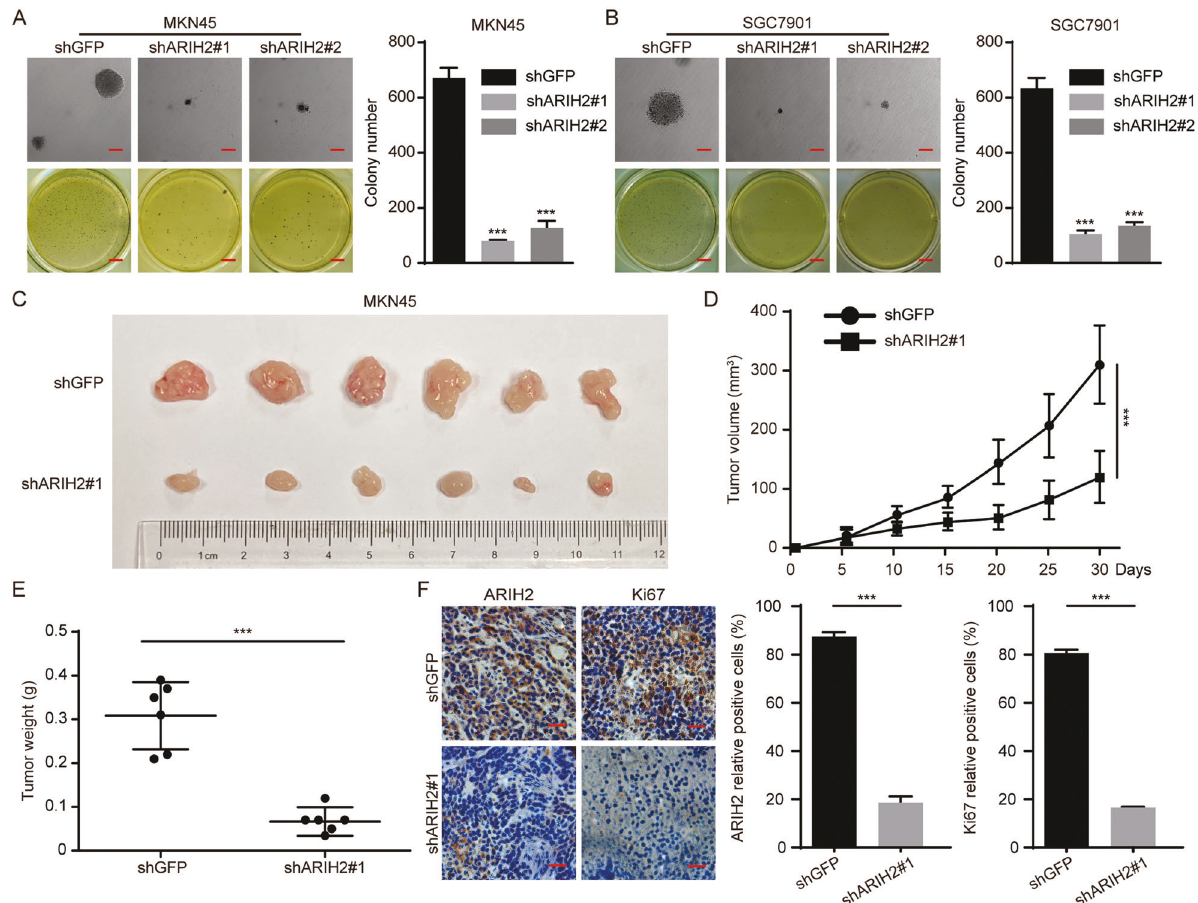
Fig. 3 ARIH2 is responsible for colony formation of GC cells in vitro and for tumor formation of GC cells in vivo. A , B Soft agar assays of the control and ARIH2-knockdown MKN45 and SGC7901 cells were performed to detect the colony formation ability. Quanti fi cation of the number of cell clones. C – E Photographs, growth monitoring and weights of the indicated xenograft tumors. Data were analyzed using two- tailed Student ’ s t tests. F IHC analysis of ARIH2 and Ki67 expression was carried out in the indicated xenograft tumors. Scale bar = 50 μ m. Quanti fi cation of ARIH2 and Ki67 expression. All data are expressed as the mean ± SD. Student ’ s t test was performed to analyze signi fi cance. * P < 0.05, ** P < 0.01, *** P <